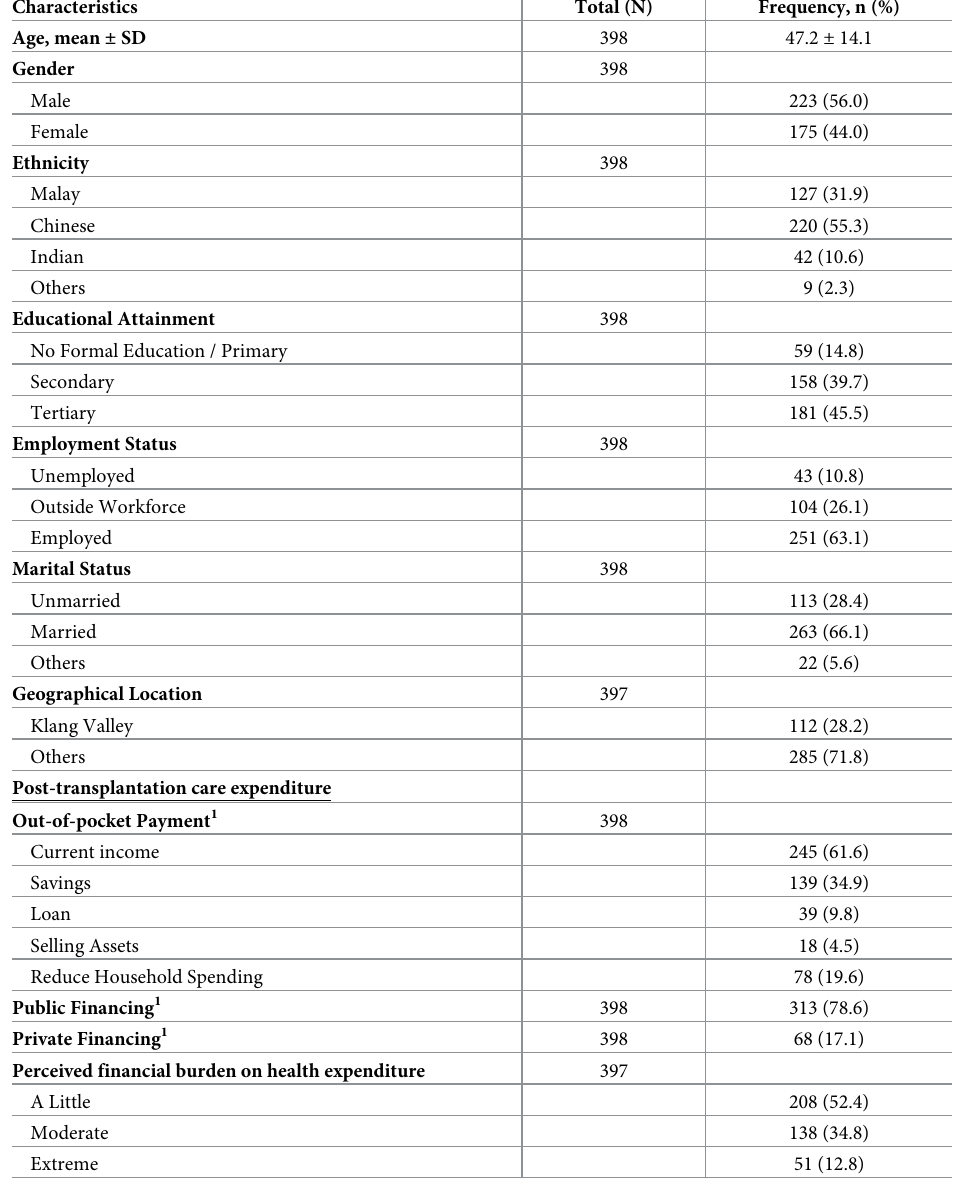
Table 1. General characteristics of kidney transplant recipients by household